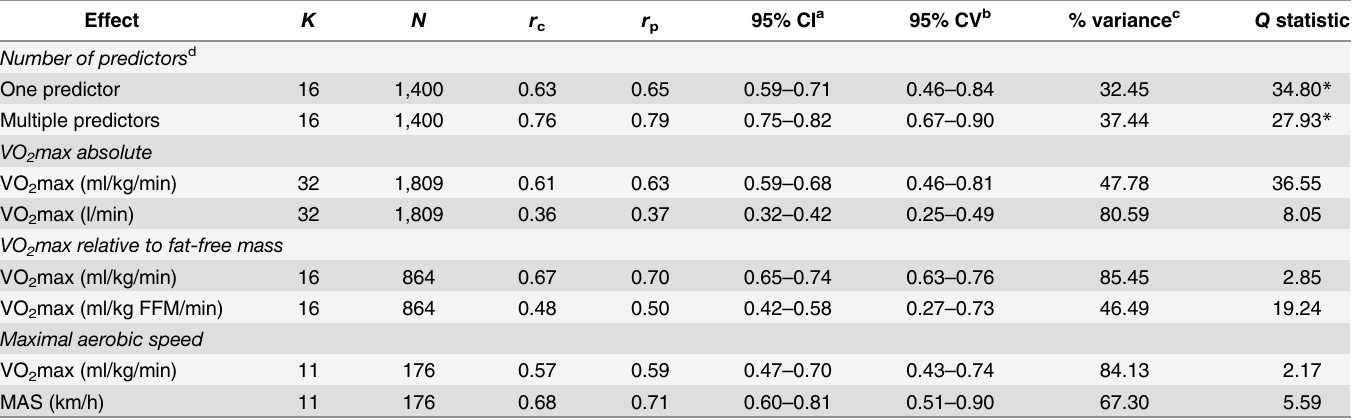
Table 3. Results of the within-study moderator analyses for criterion-related validity correlation coefficients across the distance- and time-based walk/run field tests †